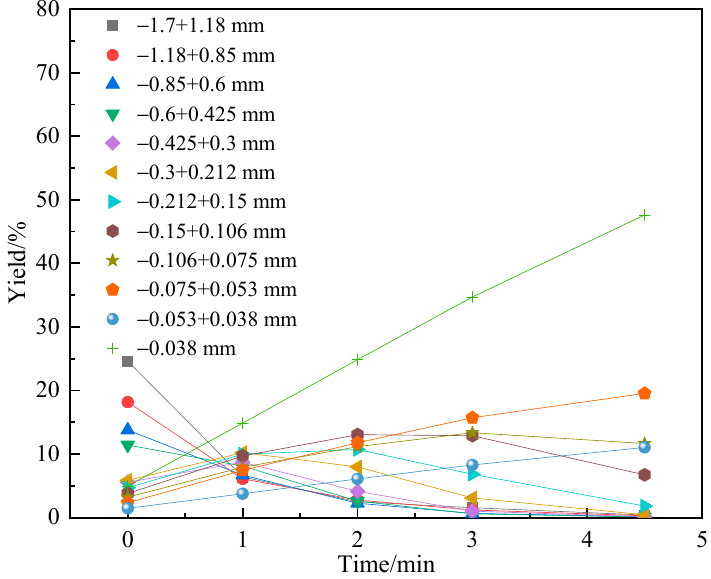
Figure 7. Product particle size composition of Gaofeng ore at different grinding times.